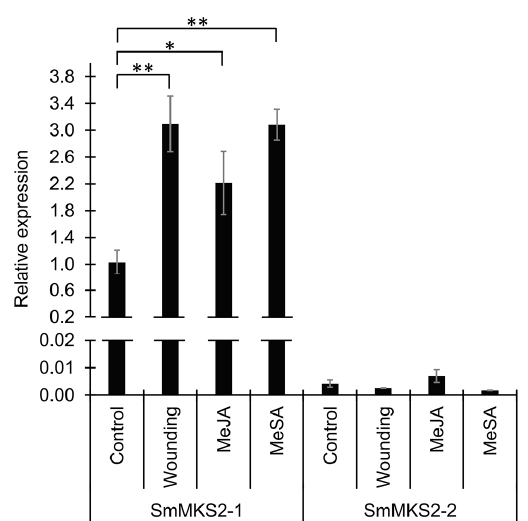
Figure 4. Expression profiles of SmMKS2-1 and SmMKS2-2 genes in response to wounding, MeJA and MeSA treatment. Values are means ± SE from three replicates. Significant differences were assessed by a Dunnett’s test: * p < 0.05, ** p < 0.01.